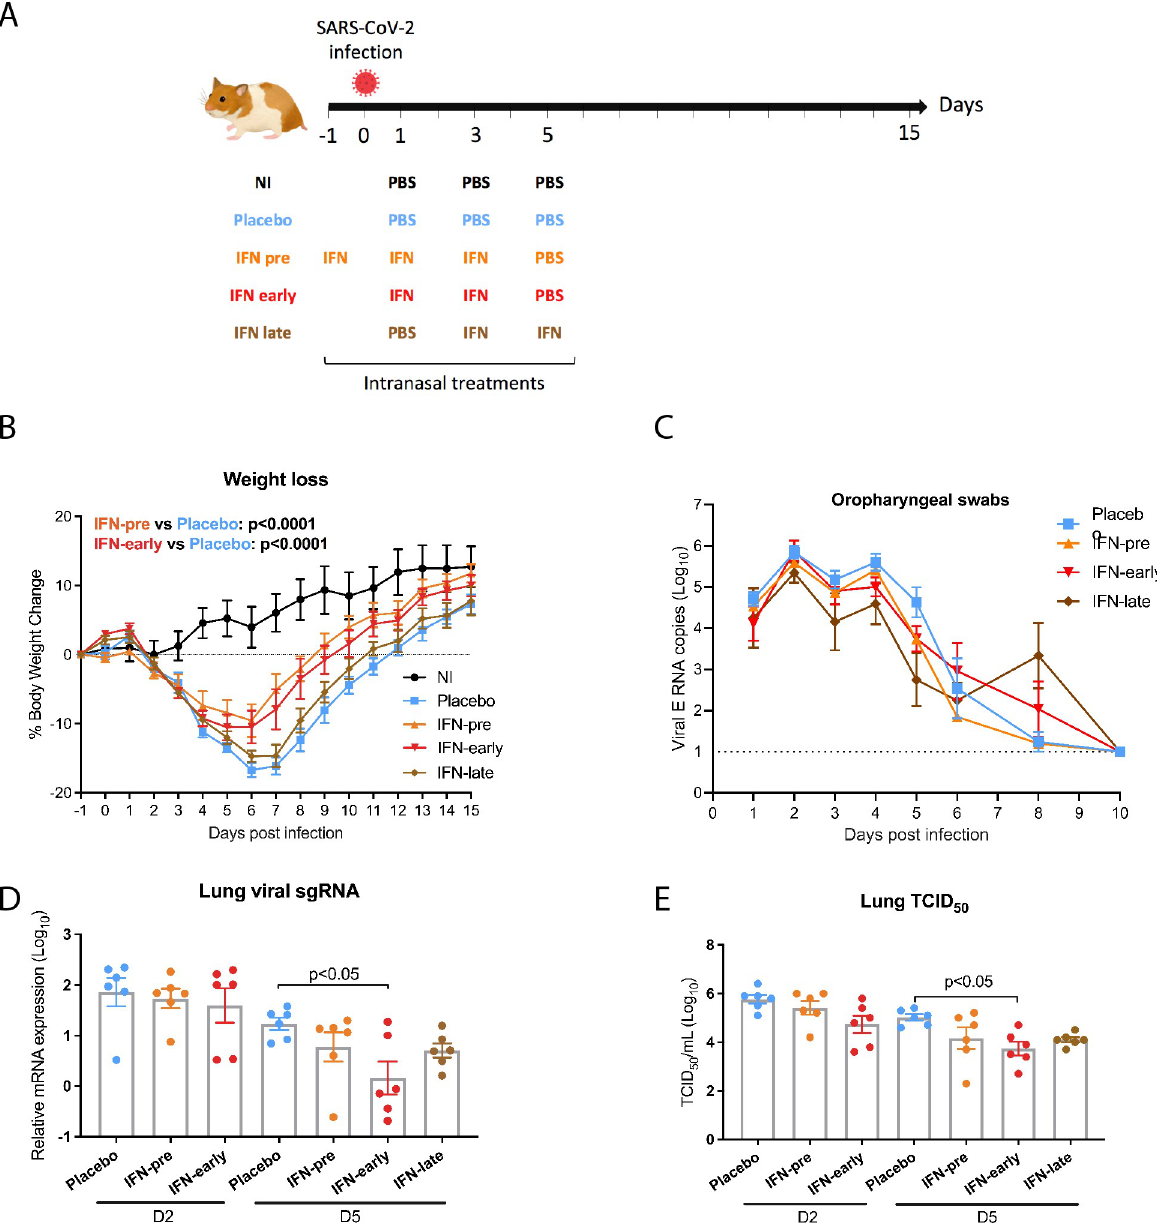
Fig 2. Impact of type I IFN- α treatment on SARS-CoV-2-induced weight loss and viral titers. (A) Overview study design. (B) Percentage of body weight change with weight measured day 1 pre-infection before the IFN-pre treatment set as the reference weight (6 animals per group). Statistical analysis: two-way ANOVA comparing treatment effects with Geisser-Greenhouse correction followed by Tukey’s multiple comparisons test. (C) . Viral genomic RNA in oropharyngeal swabs (6 animals per group). The dotted line indicates limit of detection. (D and E) Lungs viral titers determined by RT-qPCR targeting viral sgRNA relative to the housekeeping genes RPL18 and RPS6KB1 (D) and by TCID 50 (E) . D2: day 2 post infection; D5: day 5 post infection. Results are expressed as means ± SEM. Statistical analysis: one-way ANOVA with Tukey’s multiple comparisons